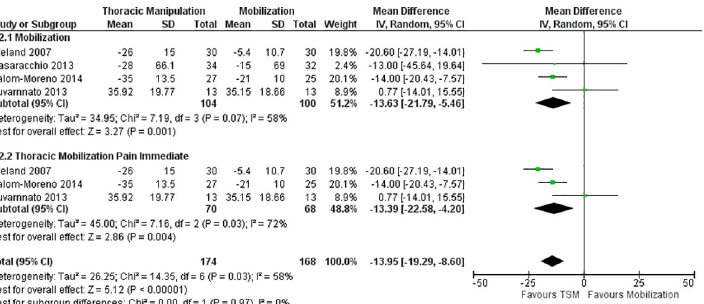
Fig 3. Meta-analysis of TSM versus mobilization for pain without a distinction between immediate and short- term follow-up.